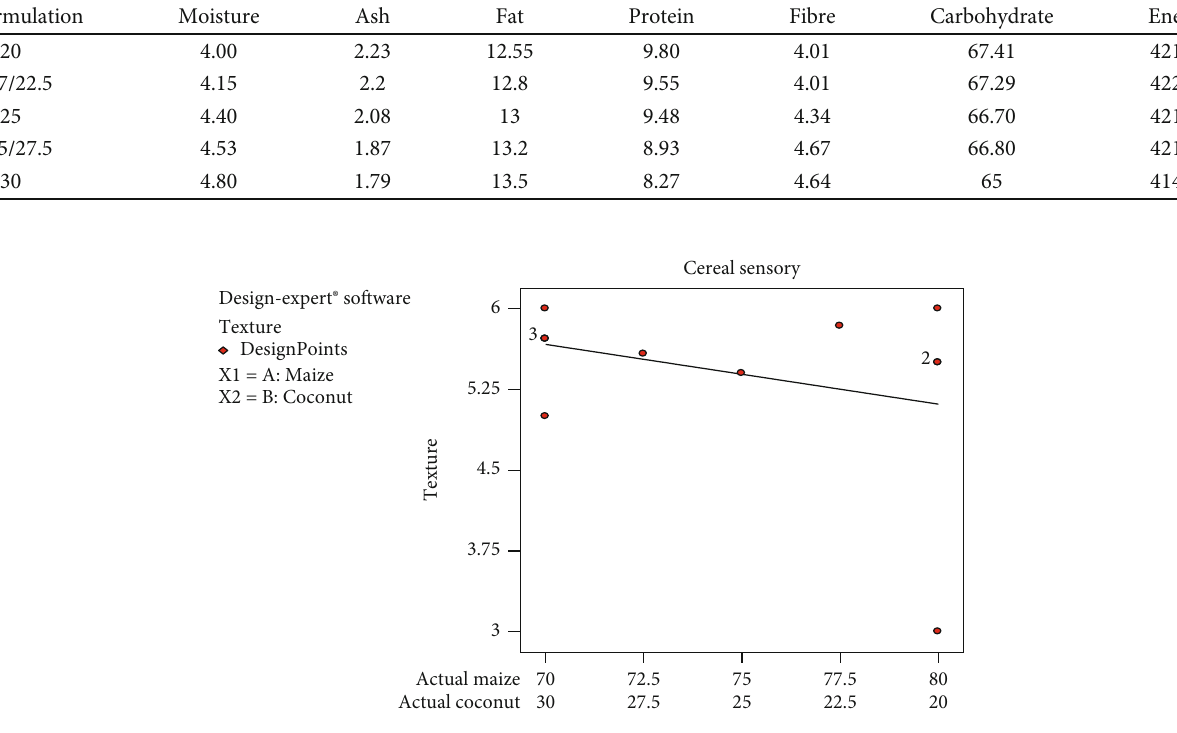
Figure 1: Mean graph for texture sensory responses on the